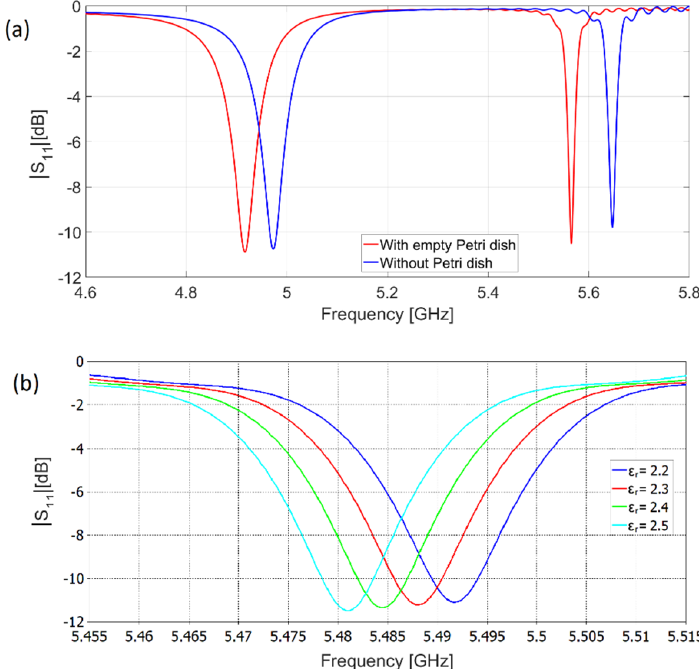
Figure 4. Modulus of the simulated scattering parameter | S 11 | of the sensor in the frequency range of interest with ( a ) empty Petri dish (red line) and no Petri dish (blue line), and ( b ) filled Petri dish at various permittivity ε r of the substance. In both cases, the Petri dish is located in the optimal position. Table 1. Simulated results pertaining to the second resonance when the substance permittivity was varied.